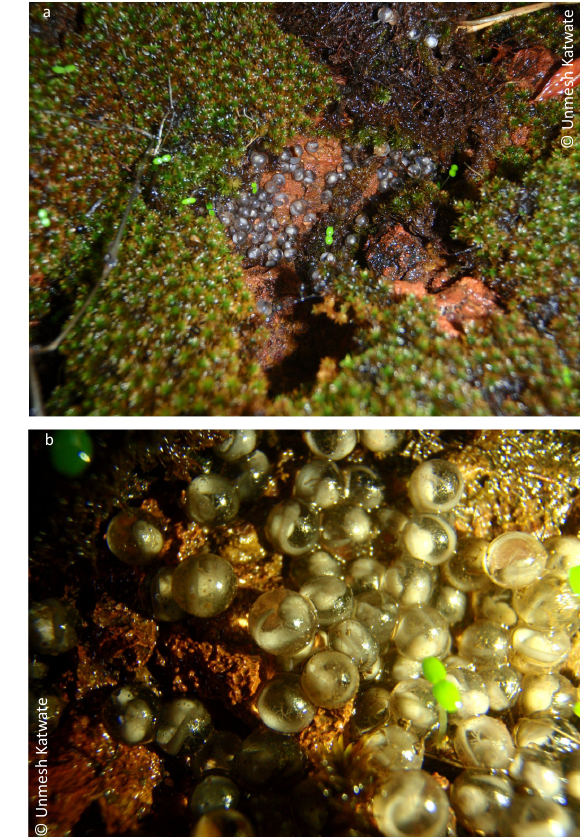
Image 8. Eggs of Indirana chiravasi sp. nov. laid in the moss on a lateritic